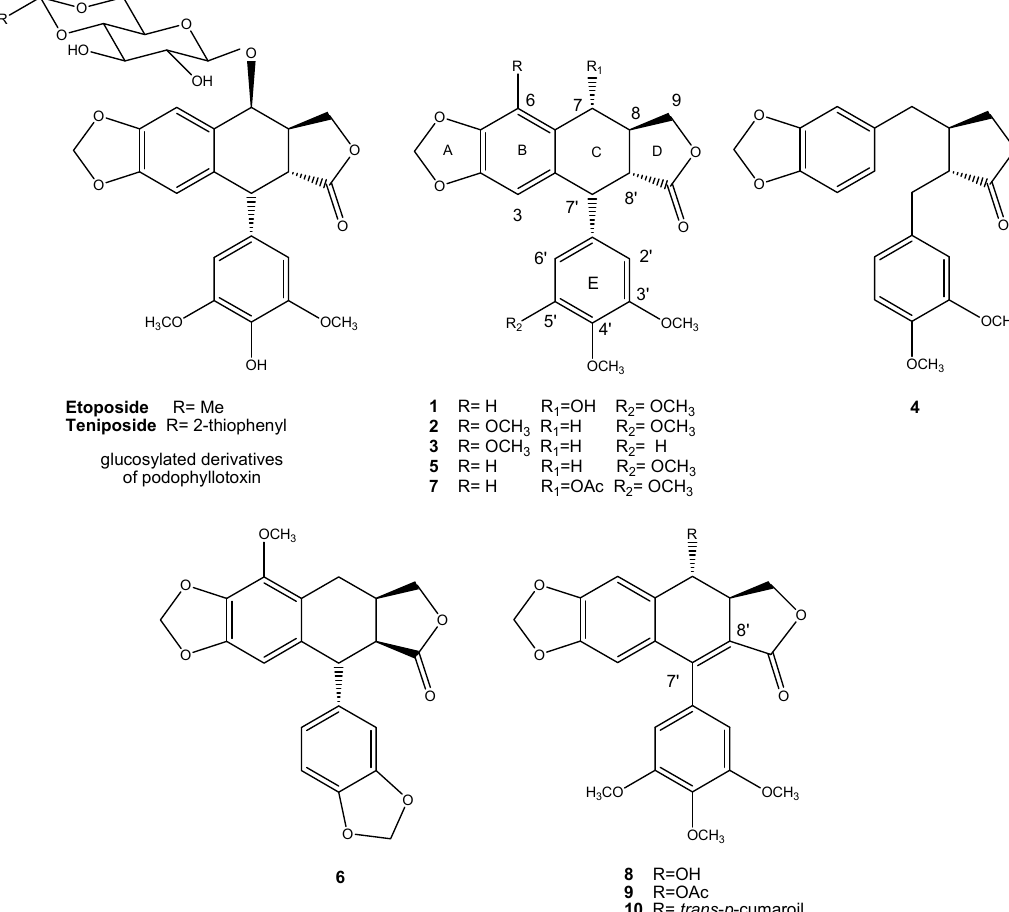
Figure 1. Glycosylated derivatives of podophyllotoxin (etoposide and teniposide) and podophyllotoxin-type lignans 1 – 10: podophyllotoxin ( 1 ), β -peltatin-A-methylether ( 2 ), 5 ′ -desmethoxy- β -peltatin-A-methylether ( 3 ), desmethoxy-yatein ( 4 ), desoxypodophyllotoxin ( 5 ), burseranin ( 6 ), acetyl podophyllotoxin ( 7 ), 7 ′ ,8 ′ -dehydropodophyllotoxin ( 8 ), 7 ′ ,8 ′ -dehydroacethyl podophyllotoxin ( 9 ), and 7 ′ ,8 ′ -dehydro trans-p -cumaroylpodophyllotoxin ( 10 ), isolated from the steam bark of Bursera fagaroides .